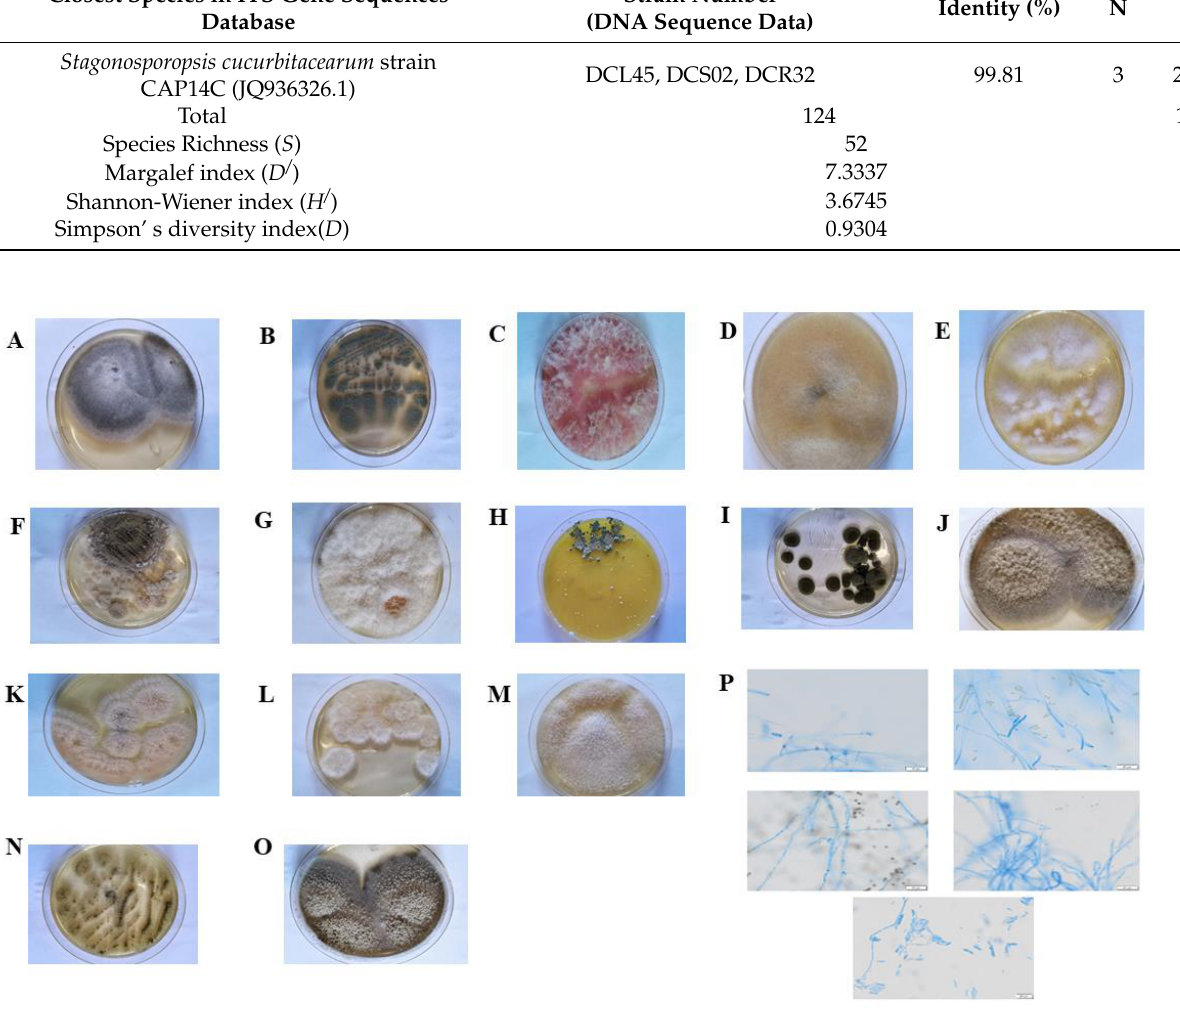
Figure 1. The morphology of various endophytic fungal colonies after incubation at 25 ◦ C for 7 days: ( A ) Cladosporium sp. colony morphology showed brown or black colonies with dark-pigmented conidia; ( B ) Phoma sp. colony morphology showed brown chlamydospores that are arranged singly or in chains; ( C ) Pestalotiopsis oryzae colony morphology showed brown or dark brownish colonies with slimy conidial masses protruding from the surface; ( D ) Mucor fragilis colony morphology showed fluffy, white to dark-grey colonies with the development of sporangia; ( E ) Botrytis cinerea colony morphology showed whitish to greyish sclerotia colonies with short mycelium without sporulation; ( F ) Phomopsis sp. colony morphology showed white to brown hyphae and black fruiting bodies; ( G ) Colletotrichum gloeosporioides colony morphology showed white, fluffy, dense, light grey colonies with masses of conidia; ( H ) Trametes versicolor colony morphology shows whitish to light brown colonies with leathery texture; ( I ) Fusarium graminearum colony morphology showed pale or bright- colonies with a cottony aerial mycelium; ( J ) Xylariaceae sp. colony morphology showed yellow to brown colonies with scanty aerial mycelium; ( K ) Diaporthe phaseolorum colony morphology showed a white, lanose colony; ( L ) Didymella sp. colony morphology showed fluffy, whitish, grey colonies with aerial mycelia; ( M ) Fusarium oxysporum colony morphology showed whitish colonies with short conidia; ( N ) Aspergillus flavus colony morphology showed powdery masses of yellowish-green spores with cottony texture on the upper surface; ( O ) Alternaria alternata colony morphology showed green to olive-green colonies with small conidia; ( P ) Optical microscopy of mycelia of some endophytic fungi from Ageratina adenophora after incubation at 25 ◦ C for 7